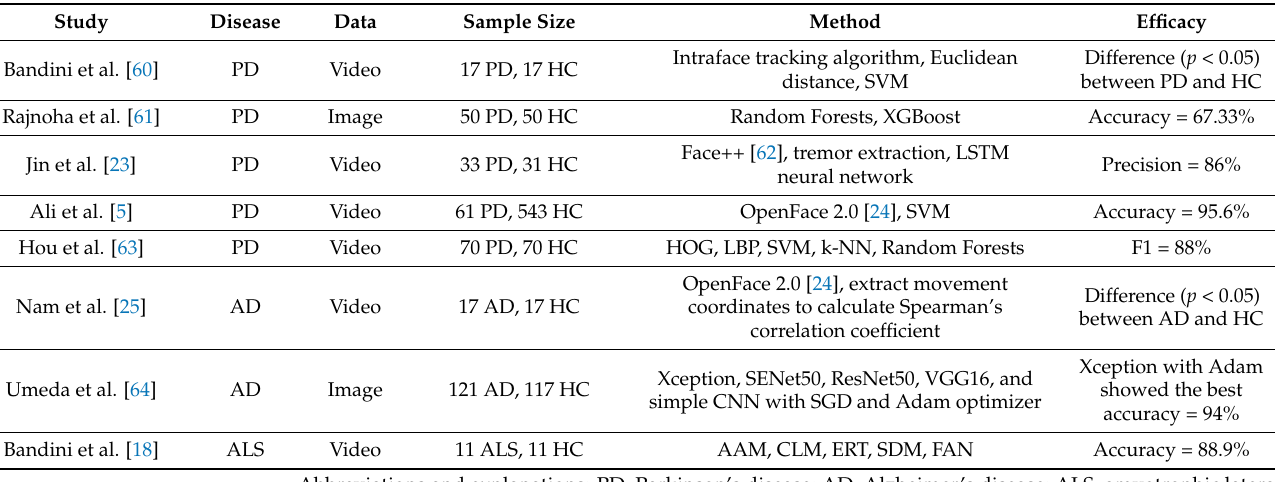
Table 3. Facial-recognition-based diagnosis system for neurodegenerative